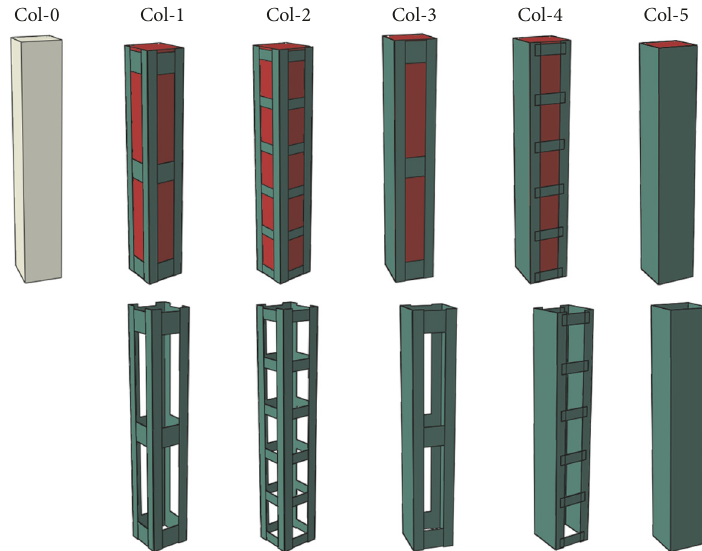
Figure 4: Finite element models of studied RC